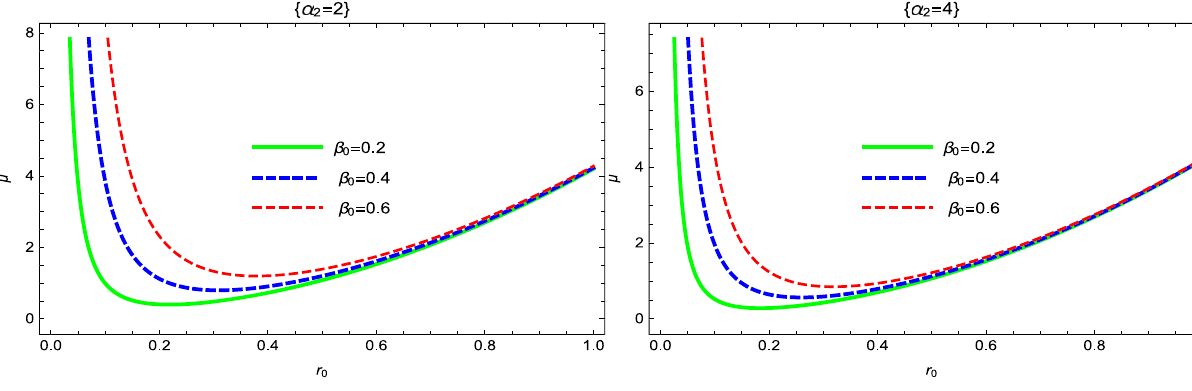
Fig. 8 Plot of Mass with fixed value of α 2 = 2 . 0 and β 0 = ( 0 . 2 , 0 . 4 , 0 . 6 ) {left} and α 2 = 4 . 0 and β 0 = ( 0 . 2 , 0 . 4 , 0 . 6 ) {right}